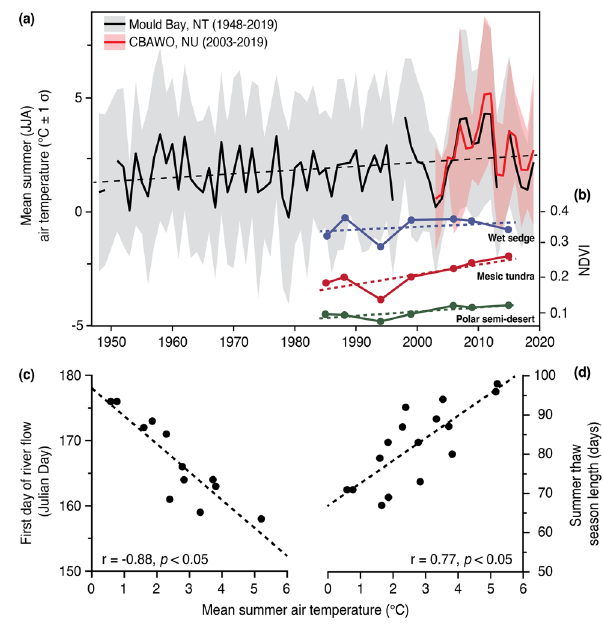
Fig. 2 Regional hydrometeorology. a Local mean summer (Jun-Aug; JJA) air temperature for the CBAWO is signi fi cantly correlated ( r = 0.99, p < 0.05); (2003 – 2019) with the longer-term mean summer air temperature at Mould Bay (1948 – 2019; 300 km west). Warming temperatures correlated with: ( b ) increased normalized difference vegetative index (NVDI) for all vegetation types at the CBAWO (modi fi ed from Edwards and Treitz, 2017); ( c ) earlier fi rst day of river fl ow and ( d ) an increase in the summer thaw season length ( p < 0.05). Mould Bay data licensed under the Open Government License –